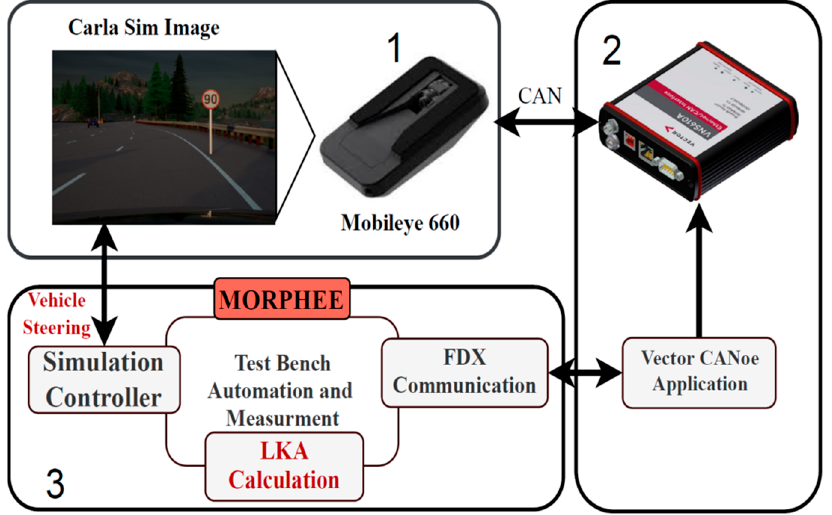
Figure 11. Block diagram of lane-keeping algorithm test run on HiL closed-loop setup. 1—Hardware part of framework, sensor and screen, 2—Can communication block VN5110A plus part of framework, sensor and screen, 2—Can communication block VN5110A plus harness and harness and Canoe, 3—Morphee automation software block with LKA algorithm implemented. Canoe, 3—Morphee automation software block with LKA algorithm